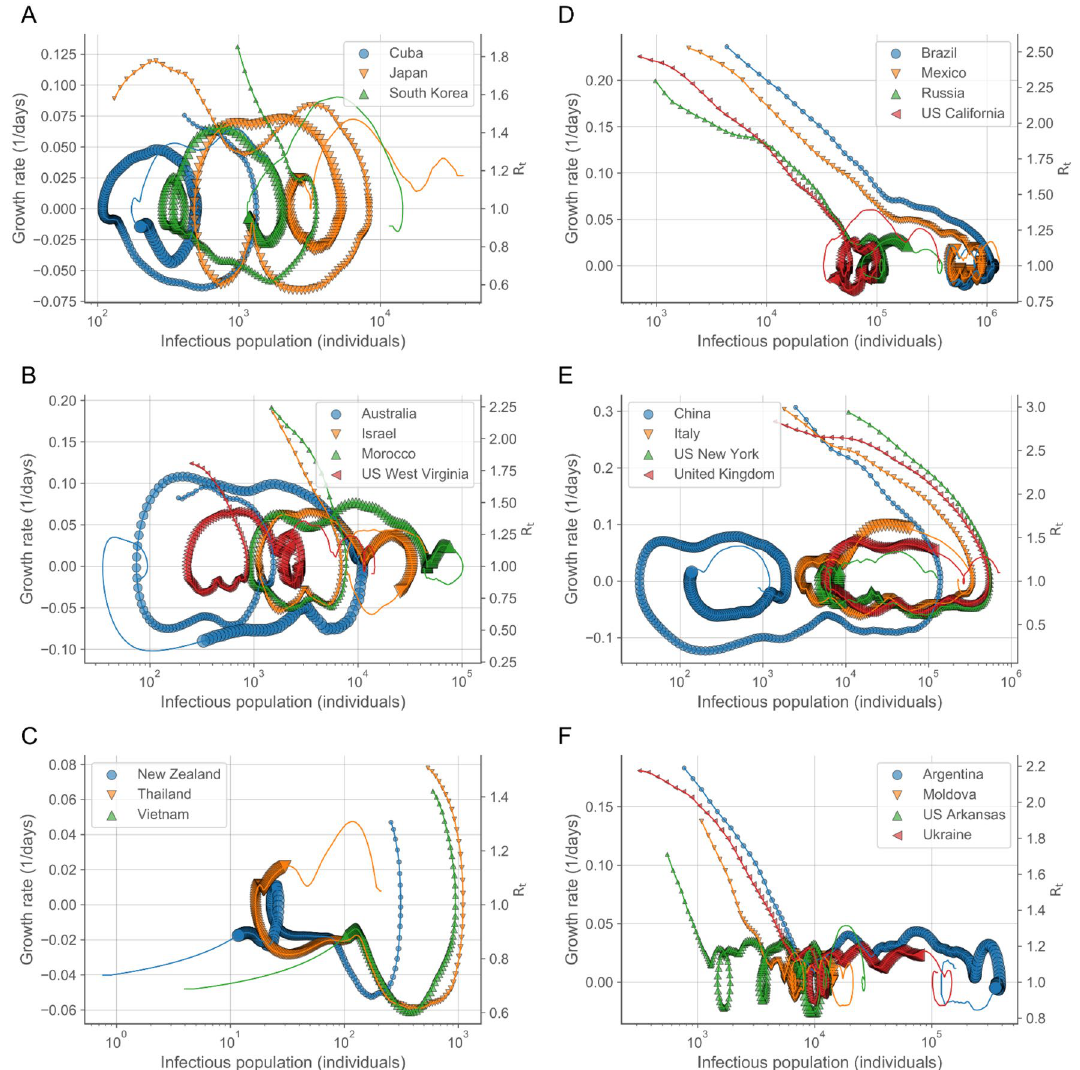
Figure 2. Trajectories in the growth rate-infectious population space followed prototypical types of behavior in the first-middle stages of the outbreak. Each day is indicated by a symbol increasing in size with time. The largest symbol corresponds to October 1, 2020. Complete trajectories, up to December 30, 2020, are indicated by the colored lines. The right axes indicate the growth rate in the scale of the reproduction number as R t = 1 + k G ( t )τ G (See “Methods: Reproduction number”). In all cases in the figure, the trajectory starts with positive growth rate ( R t > 1 ) at the smallest symbol and moves rightwards increasing the infectious population until the growth rate becomes negative ( R t < 1 ), at which point the infectious population starts to decrease and the trajectory moves leftwards. After the growth rate changes to negative values, the trajectories exhibit multiple types of differentiated behavior that can be classified in several groups depending on the extent of the initial and subsequent growth. If the growth rate reverts to positive values, the trajectory would move rightwards again. Common types of behavior include initial containment ( A – C ) with subsequent minor increases ( A ), amplified resurgence ( B ), and a sustained regression ( C ) of the outbreak; and initial amplification ( D – F ) with slow convergence to zero growth ( D ), convergence to negative growth ( E ), and fast convergence to initial sustained residual positive growth ( F ). The prefix "US " has been added to the name of the locations in the US. Confidence intervals for the growth rates and infectious population are provided in Supplementary Fig.